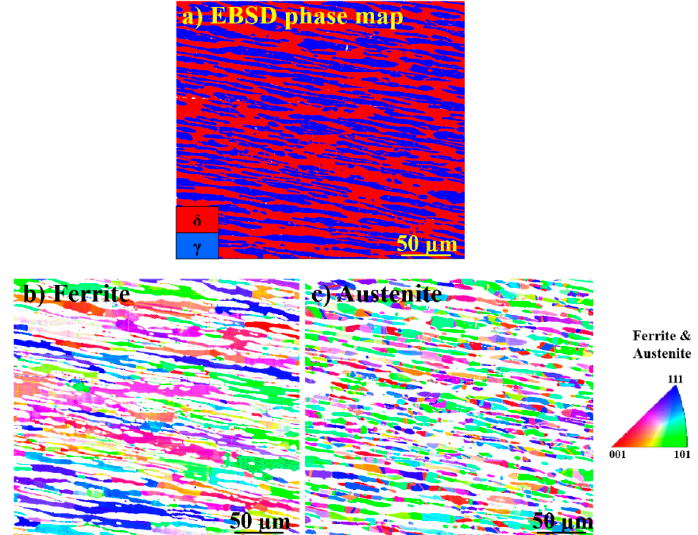
Figure 3. ( a ) Electron backscattered diffraction (EBSD) phase map of the SDSS before arc heat treatment, showing the approximate 50:50 ferrite ( δ ) to austenite ( γ ) ratio. No traces of any additional phases were found. ( b , c ) Inverse pole figures of δ and γ .